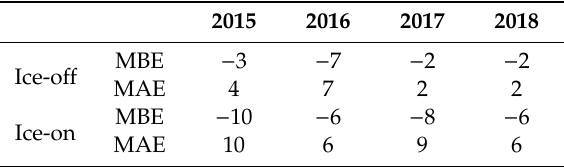
Table 4. Mean bias and mean absolute errors for the pixel-by-pixel extraction of lake ice phenology events (ice-o ff and ice-on) using the Otsu method.